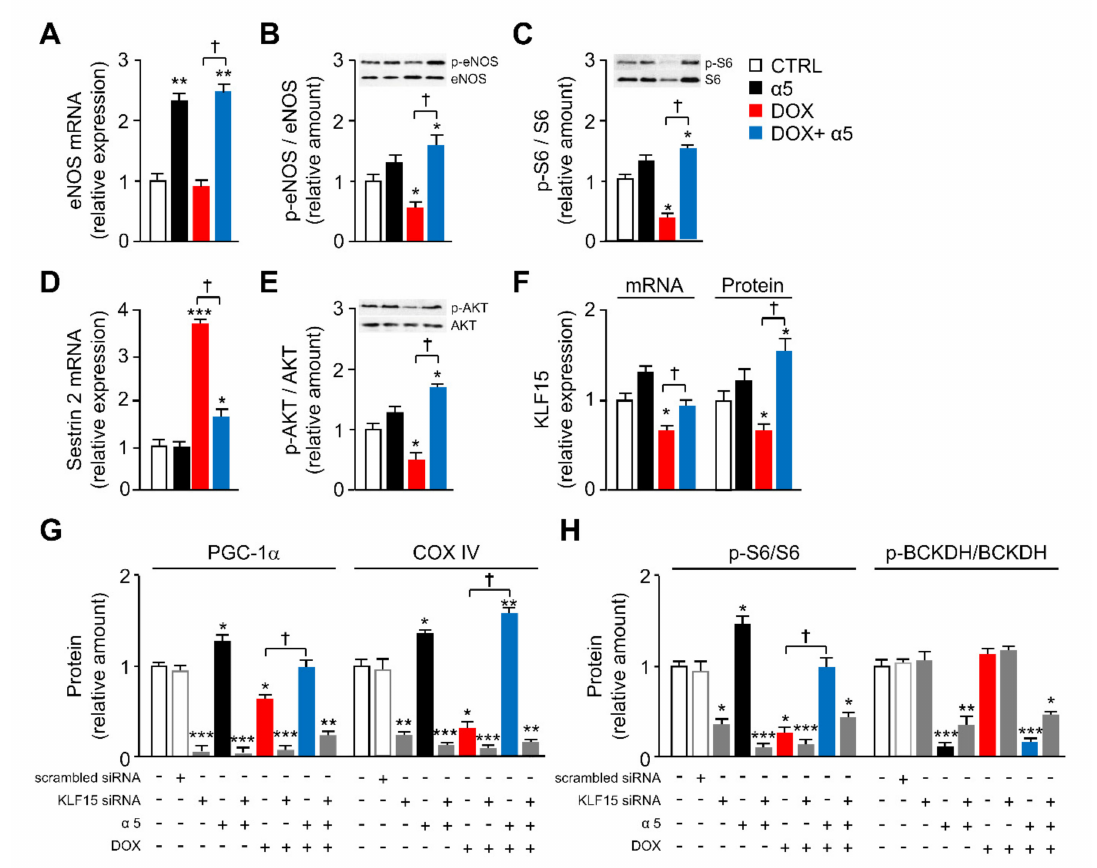
Figure 7. Di ff erent signaling pathways are implicated in the protective e ff ects of α 5 supplementation in DOX-treated HL-1 cardiomyocytes. ( A , D , and F ) Gene expression. ( A ) eNOS, ( D ) Sestrin2, ( F ) KLF15 mRNA levels were analysed by quantitative RT-PCR. Relative expression values for the untreated (CTRL) cells were taken as 1.0 ( n = 5 experiments). ( B , C , E–H ) Protein levels. ( B ) Phospho-eNOS, ( C ) phospho-S6, ( E ) phospho-Akt, ( F ) KLF15, ( G ) PGC-1 α and COXIV, and ( H ) phospho-S6 and phospho-BCKDH protein levels were detected by immunoblot analysis. The relative values were densitometricallyanalyzedandreportedasratiostototaleNOS,S6, Akt, andBCKDHlevels, respectively; KLF15, PGC-1 α , and COXIV were normalized to GAPDH. Values for untreated HL-1 cells were taken as 1.0 ( n = 5 experiments). ( G ) PGC1- α and COX IV protein levels were measured by immunoblot analysis in HL-1 cells transfected with either specific KLF15 siRNA or nontargeting siRNA, and treated with DOX or α 5 alone or in combination. Values for untreated HL-1 cells were taken as 1.0 ( n = 5 experiments). ( H ) S6 and BCKDH phosphorylation was measured by immunoblot analysis in HL-1 cells as in (H). * p < 0.05, ** p < 0.01, and *** p < 0.001 vs. untreated cells; † p < 0.05 vs. DOX-treated cells. All data are presented as the mean ±